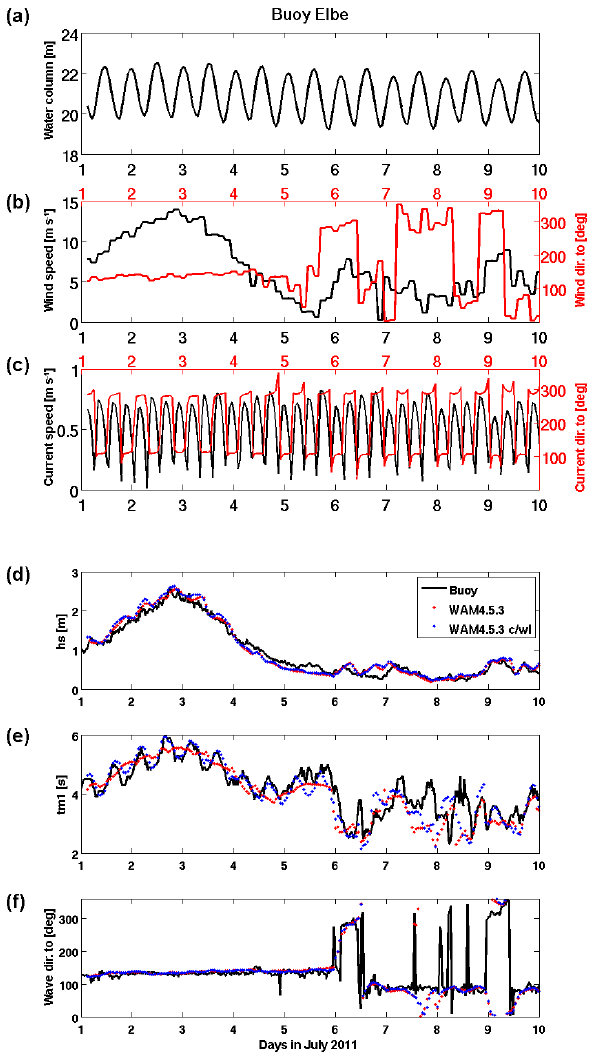
Figure 2. Time series at the buoy Elbe station (see Fig. 1 for its lo- cation) from 1 to 10 July 2011 of (a) water column (m), (b) wind speed (ms − 1 ) (black line, left axis) and wind direction (deg.) (red line, left axis); (c) surface current magnitude (black line, left axis) and current direction (red line, left axis); (d) significant wave height (m); (e) mean period tm1 (s); and (f) wave direction (%). For the patterns (d) – (f) , the black line corresponds to the buoy measure- ments, red dots correspond to coupled model simulations, blue dots correspond to the wave-only model.